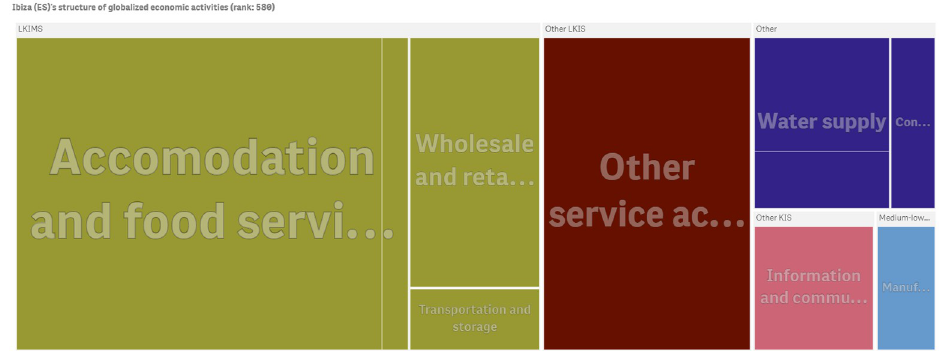
Fig 7. The economic activities of Ibiza (ES)’s firms with global presence. Ibiza ranks 580th in the economic complexity index of cities in 2010 (ECI: -0.407). The figure has been generated using Qlik Sense.